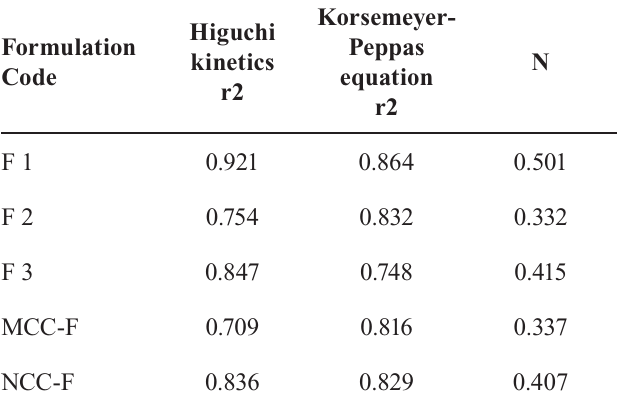
FIGURE 8 - Photograph to indicate a transparency of prepared